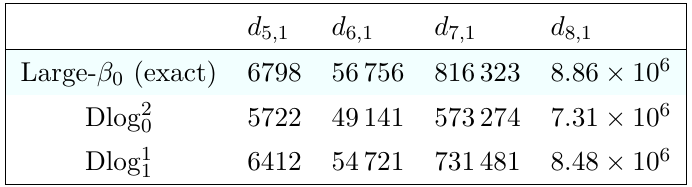
Table 1. Coefficients d n, 1 in the MS scheme from D-log Padés built to the Borel transform of Π 00 ( s ) together with their exact values in the large- β 0 limit highlighted in